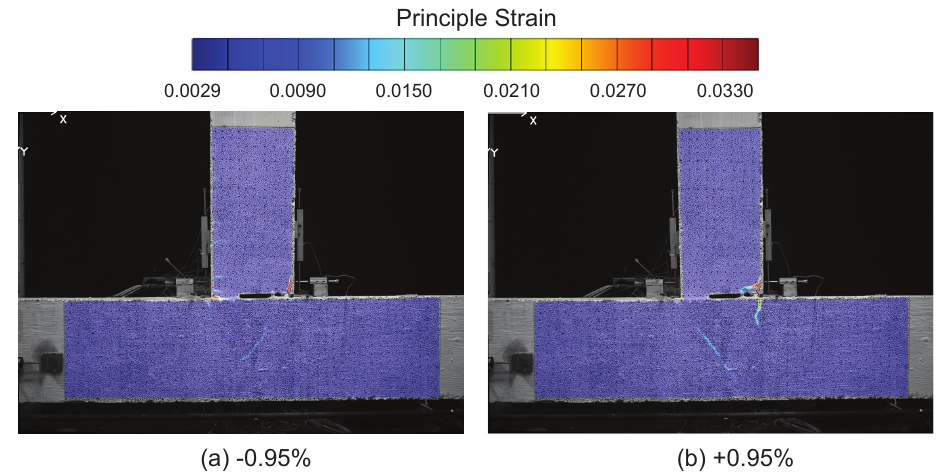
Figure 7. DIC results at a drift level of